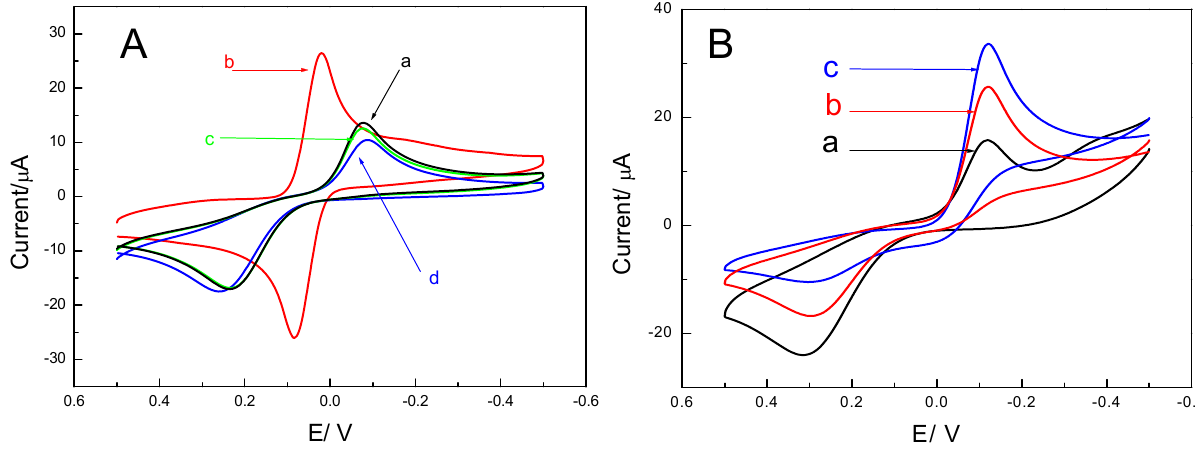
Figure 1. ( A ) Cyclic voltammograms of (a) bareGCE, (b) Au/GCE, (c) Ab1/Au/GCE, (d) BSA/Ab1/Au/GCEin pH 7.0 0.1 M PBS containing 1 mM hydroquinone. ( B ) Cyclic voltammograms of electrochemical immunosensor incubated with different concentration of antigen, (a) 0 ng/mL, (b) 20 ng/mL, (c) 50 ng/mL, and then incubated with